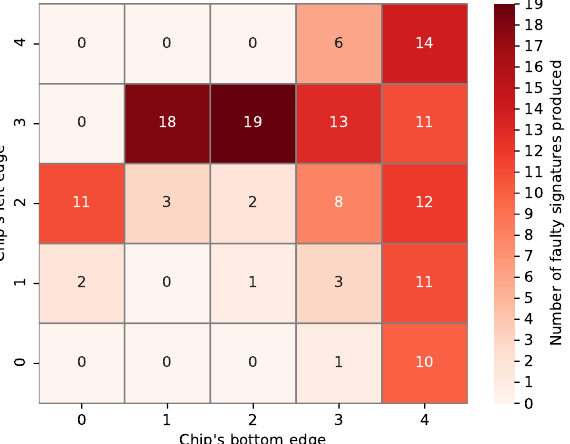
Figure 5. Heat map of vulnerable points after running the experiment 19 times, using a 5 × 5 grid. Each cell value represents the number of times a successful faulty signature was returned from the program while the DUT itself continued execution and did not